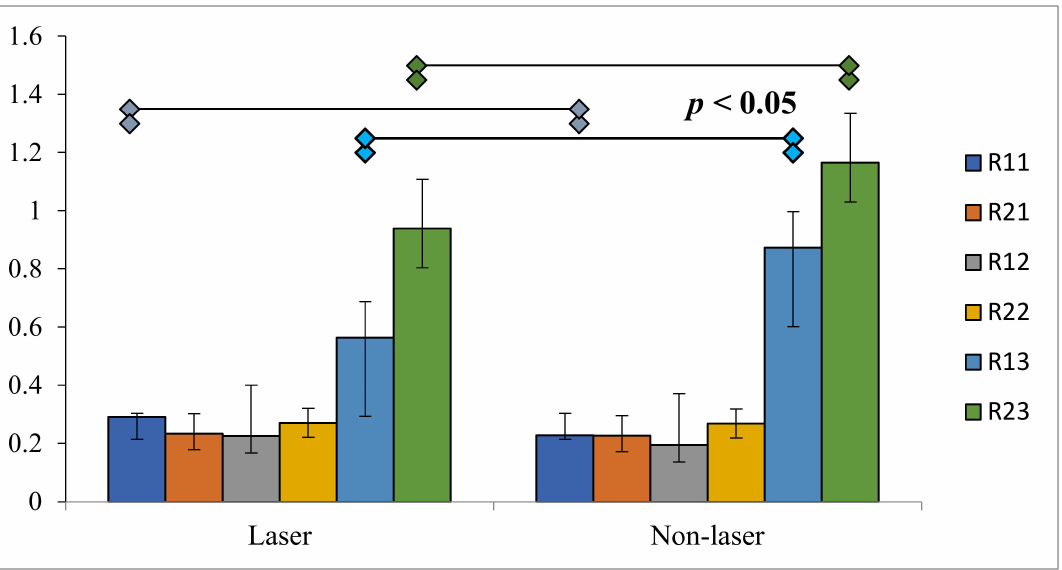
Figure 4. Graphical representation of significance differences in root resorption within intra-group comparison of laser and non-laser